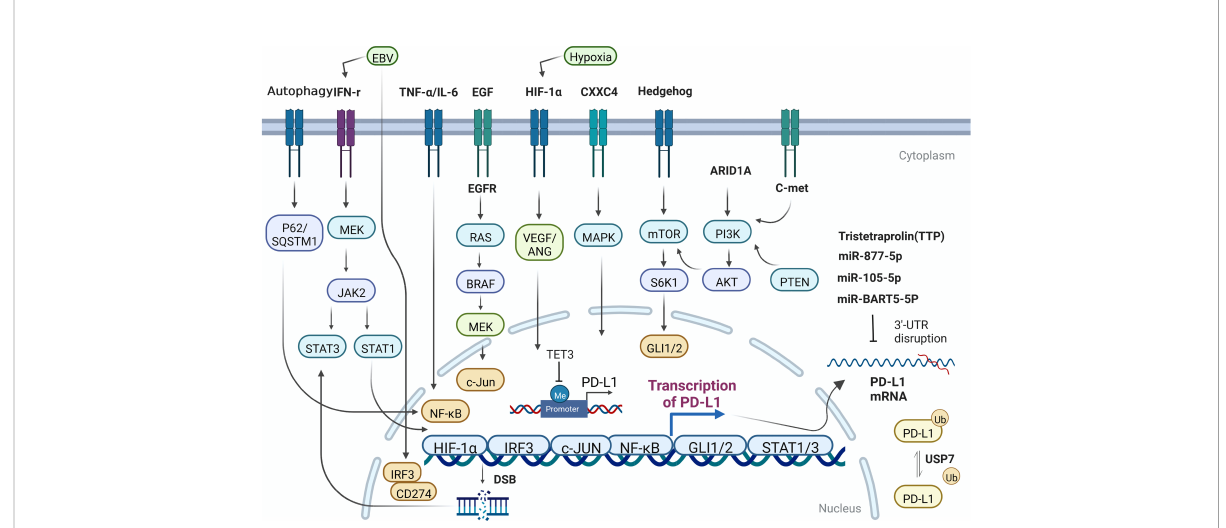
FIGURE 1 The regulatory mechanism of PD-L1 expression in GC cells. Me, methylation; Ub,